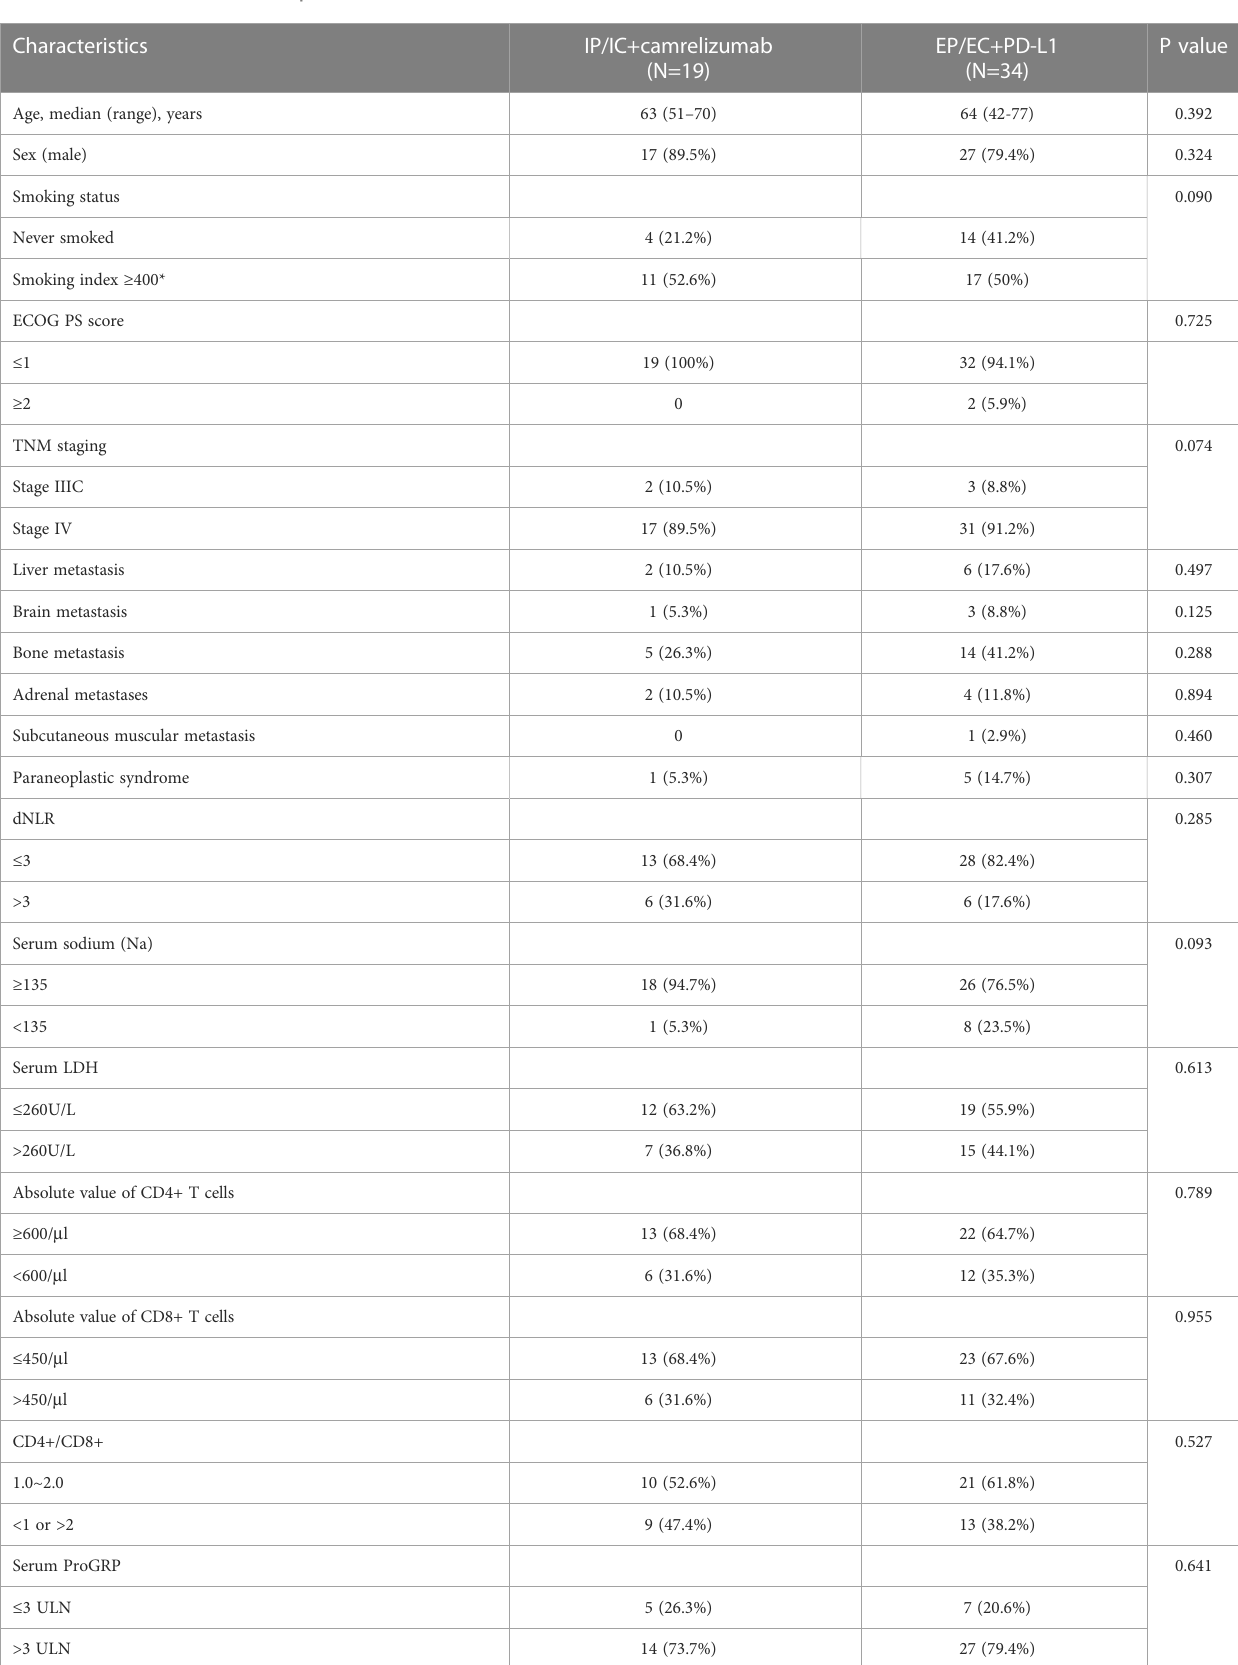
TABLE 1 Baseline characteristics of